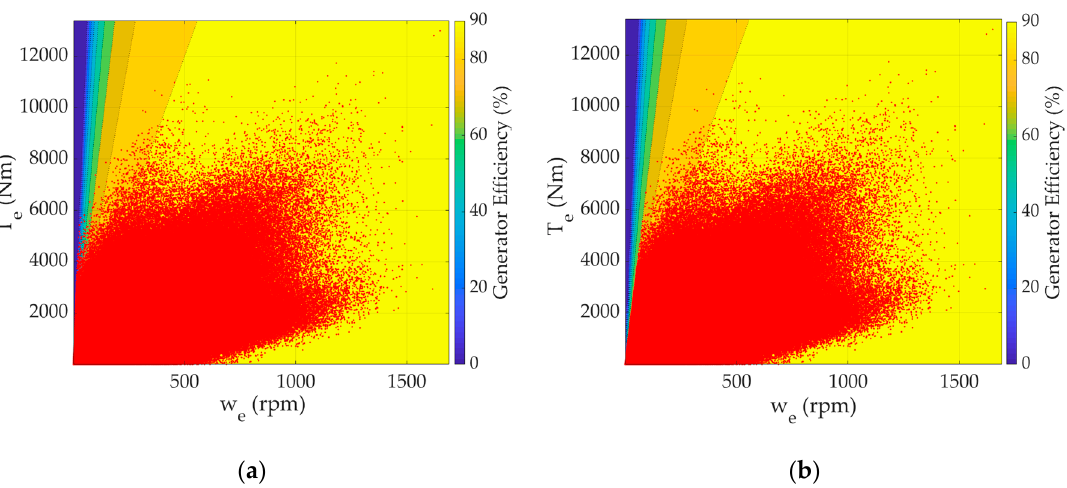
Figure 10. March generating efficiency contour map. ( a ) Generating points without any efficiency constraint. ( b ) Generating points with 70% efficiency constraint.